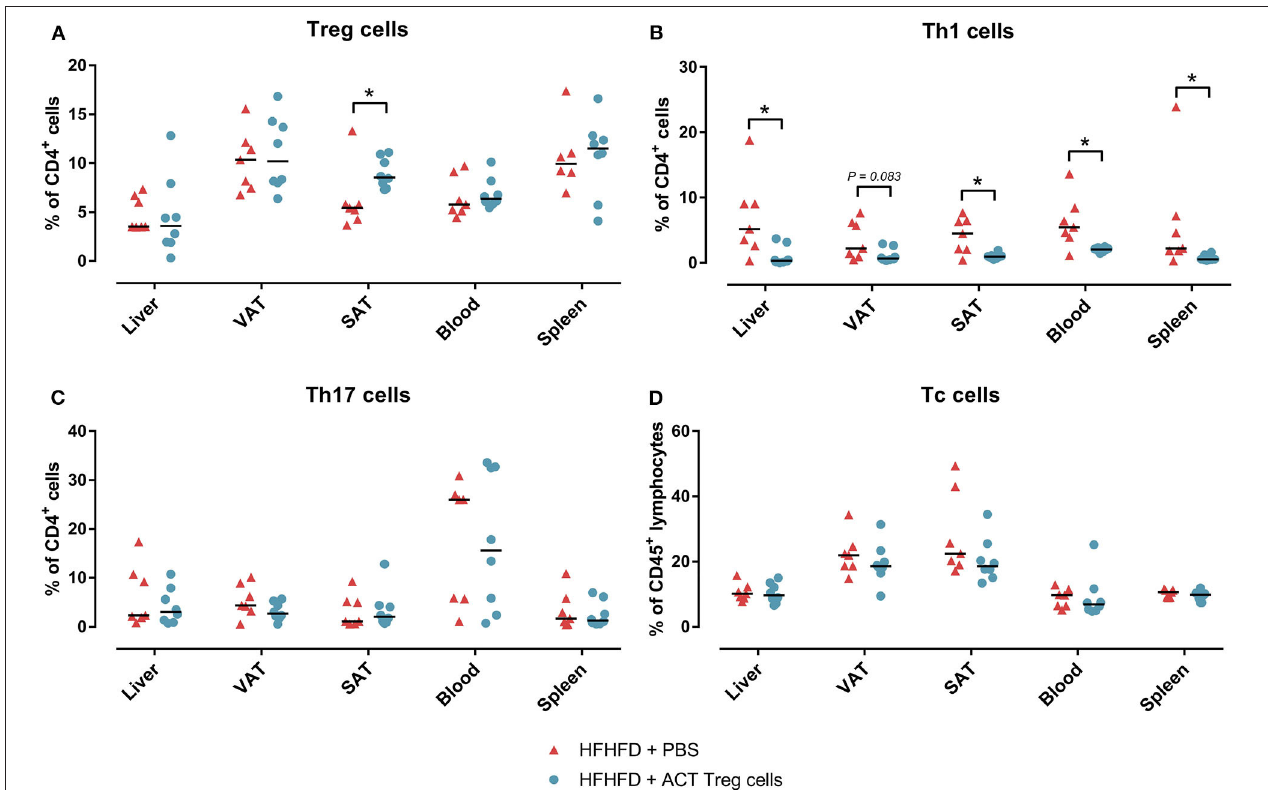
FIGURE 2 | The effect of adoptive Treg cell transfer on (A) Treg, (B) Th1, (C) Th17, and (D) Tc cell numbers in liver, VAT, SAT, spleen, and blood. Medians are depicted with a horizontal black line. * P < 0.05 (Mann Whitney U). ACT, adoptive cell transfer; PBS, phosphate-buffered saline; SAT, Tc, cytotoxic T; Th1, T helper 1; Th17, T helper 17; SAT, subcutaneous adipose tissue; VAT, visceral adipose